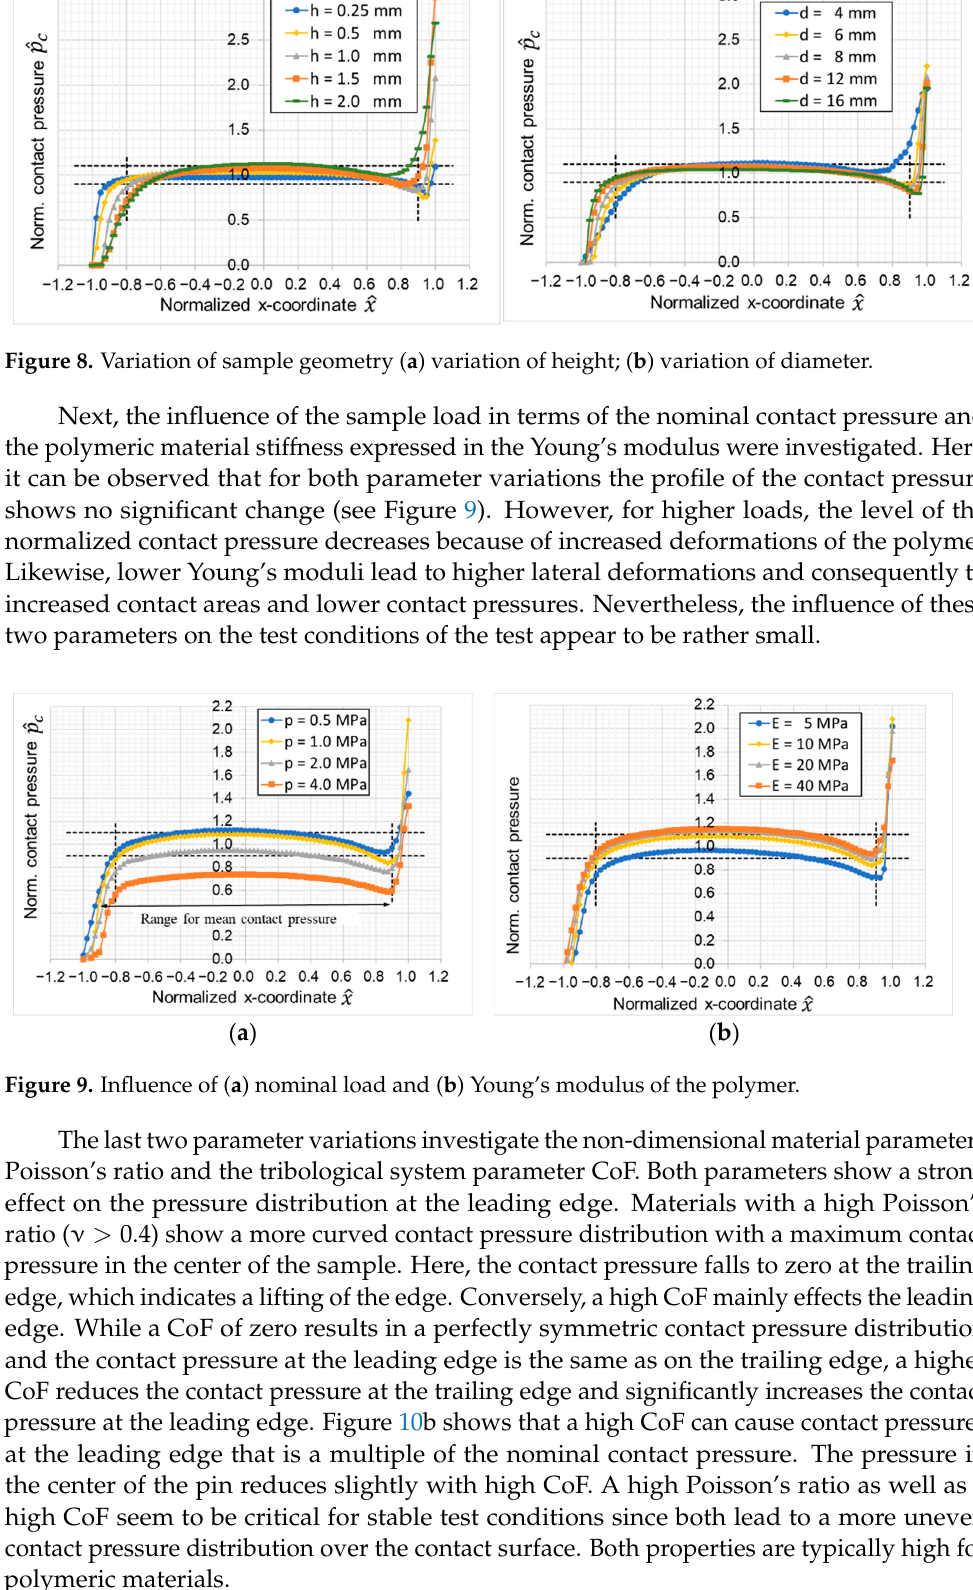
Figure 10. Influence of ( a ) Poisson’s ratio and ( b ) coefficient of friction. The investigated study shows similar influences on the contact pressure distribution for varying the polymer disc height and diameter. A similar effect could also be observed for varying nominal contact pressure and the Young’s modulus. The influence of the Pois- son’s ratio and the CoF on the contact pressure distribution are more complex and effect the contact pressure distribution differently. To evaluate the contact pressure distribution, the area of the contacting surface with a contact pressure in range ±10% of the nominal contact pressure is computed and com- pared to the nominal contact area. For different height to diameter ratios, here, a linear relationship could be found (see Figure 11a). For a minimum 90% of the contact area ful- filling this condition the ratio between height and diameter should be less than 1/6. Note